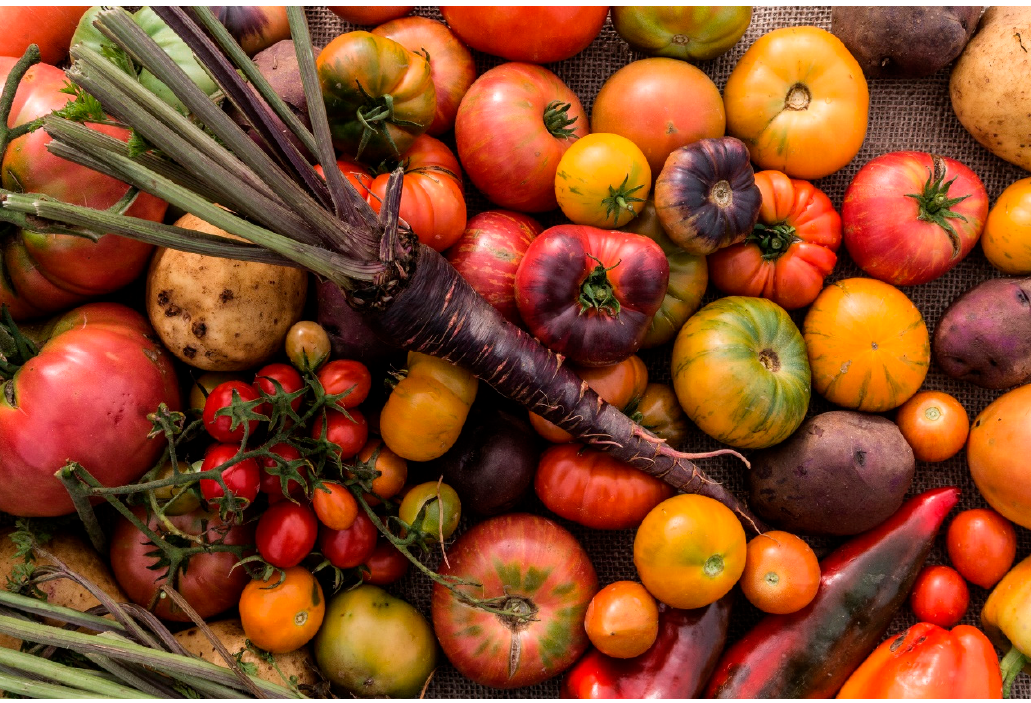
Figure 1. Diversity in fruit, root, and tuber size and color of heirloom cultivars of capsicum, carrot, potato, and tomato. Photo credit: University of Wisconsin—Madison College of Agricultural and Life Sciences.